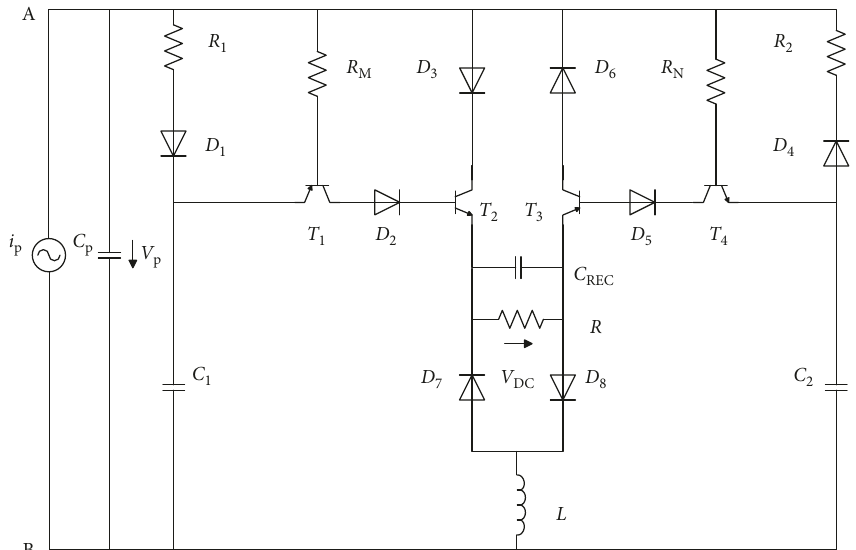
Figure 4: Schematic of the self-powered optimized synchronized switch harvesting on inductor circuit.